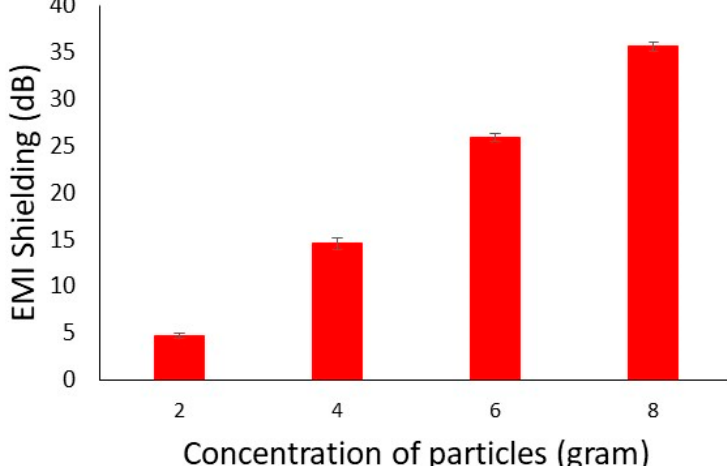
Figure 14. EMI SE of Conductive composites at higher frequency (2.45 GHz).